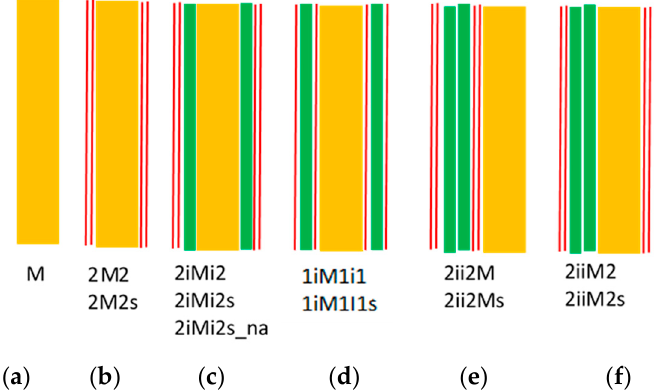
Figure 2. Cross section of specimens for out-of-plane loading: ( a ) M; ( b ) 2M2 or 2M2s; ( c ) 2iMi2 or 2iMi2s or 2iMi2s_na; ( d ) 1i1M1i1 or 1i1M1i1s; ( e ) 1ii1M or 2ii2Ms; and ( f ) 2iiM2 or 2iiM2s.